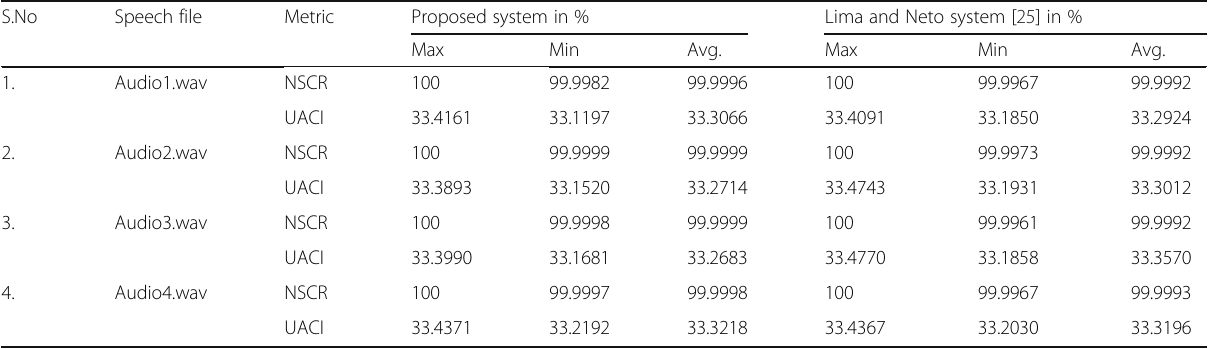
Table 3 Robustness test analysis